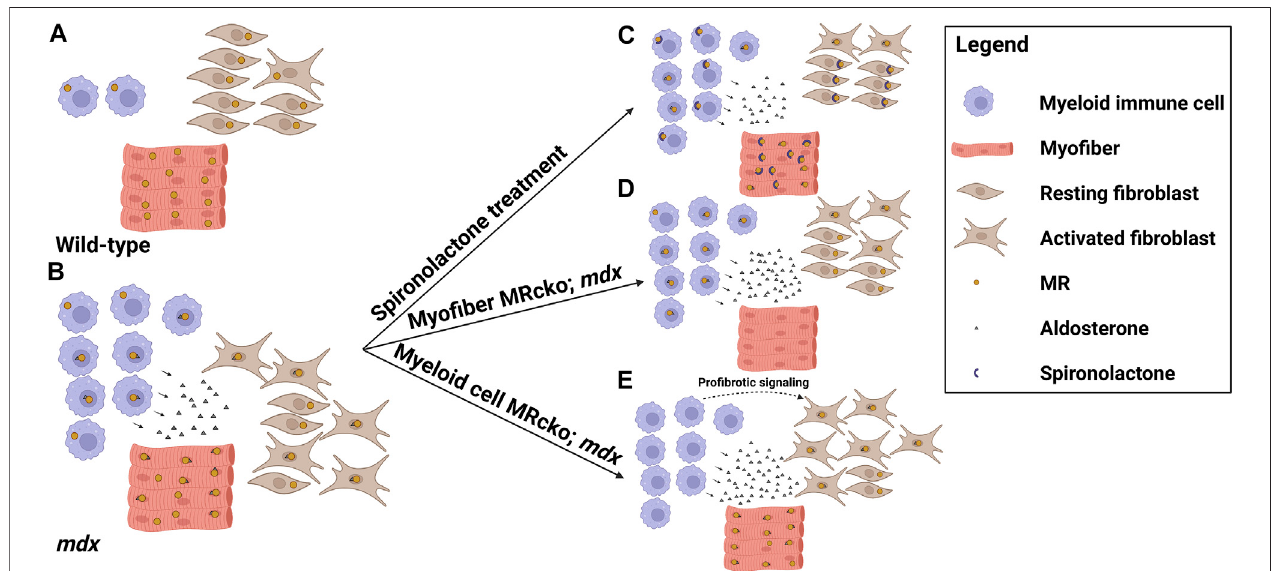
FIGURE 1 | MR signaling in the dystrophic skeletal muscle microenvironment. Model showing the distribution of cell types, mineralocorticoid receptor (MR) expression, and aldosterone production in the striated muscle microenvironments of (A) wild-type mice and (B) dystrophic mdx mice, and the effects on these parameters by altering MR signaling in (C) mdx mice treated with the MR antagonist spironolactone, (D) mdx mice with a myo fi ber-speci fi c MR knockout, and (E) mdx mice with a myeloid cell-speci fi c MR knockout. Spironolactone-treated dystrophic mice display reduced in fl ammation, fi brosis, and overall damage in response to MR sequestration and inhibition by spironolactone. Myo fi ber MR knockout in the increased aldosterone concentration present in the mdx muscle microenvironment recapitulates some of the bene fi cial effects of spironolactone treatment, including reduced fi brosis and increased muscle force. Myeloid cell MR knockout in dystrophic muscle increases fi brosis,possibly due to pro fi broticsignaling from theMR-de fi cient myeloid cells contributing to fi broblast activation(Figurewasmade with Biorender).